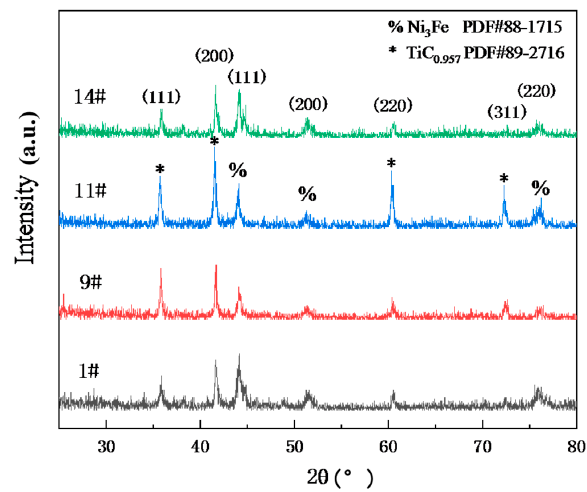
Figure 5. XRD spectrum.